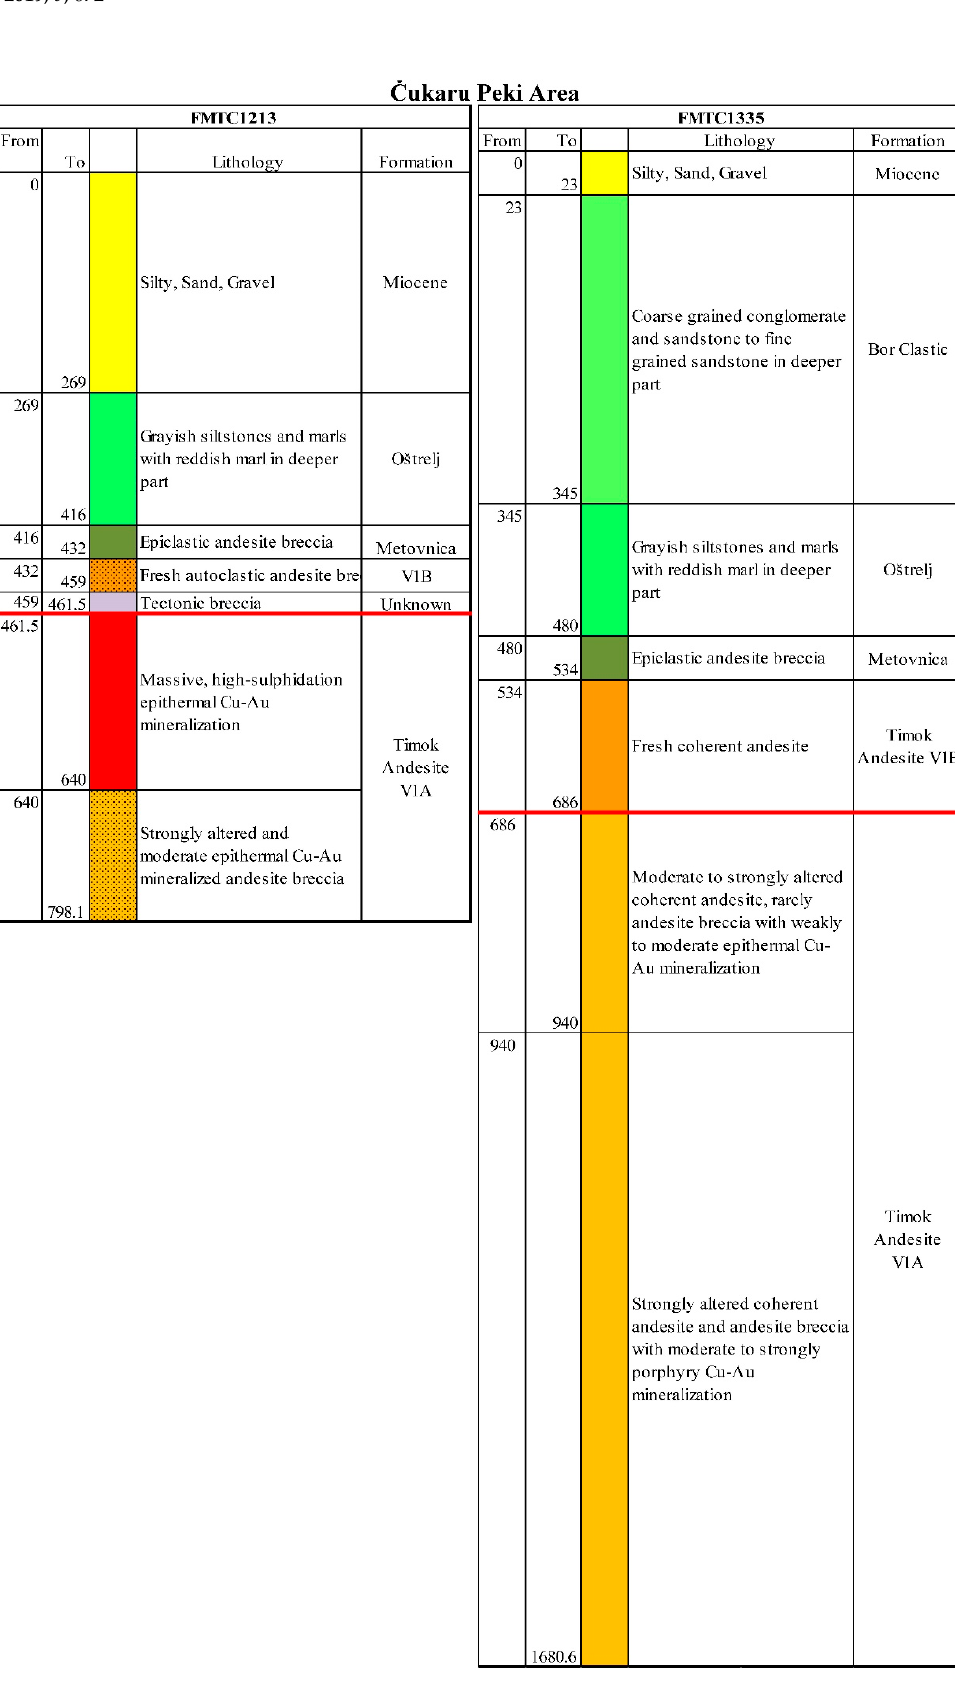
Figure 4. Stratigraphic logs of two drill holes from the Č ukaru Peki area (News Release Reservoir Minerals [21,49]). The hatched pattern indicates andesite breccia, whereas the red line marks the boundary between the two andesite subgroups.